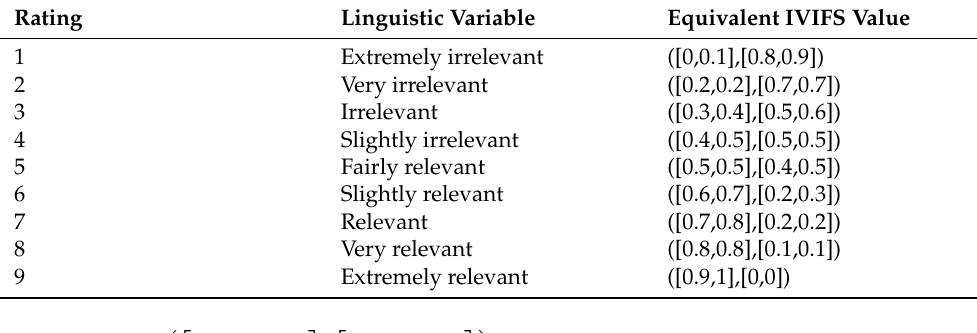
Table 2. Linguistic evaluation scale for the priority weights of the